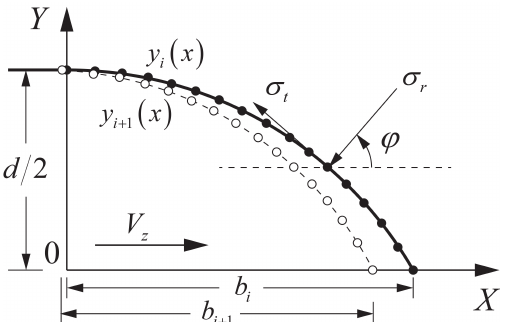
Figure 6. Diagram of the projectile’s nose during penetration. The solid line represents the projectile profile y i ( x ) at time step t i and the dotted line represent the projectile profile y i + 1 ( x ) at the subsequent time step t i + 1